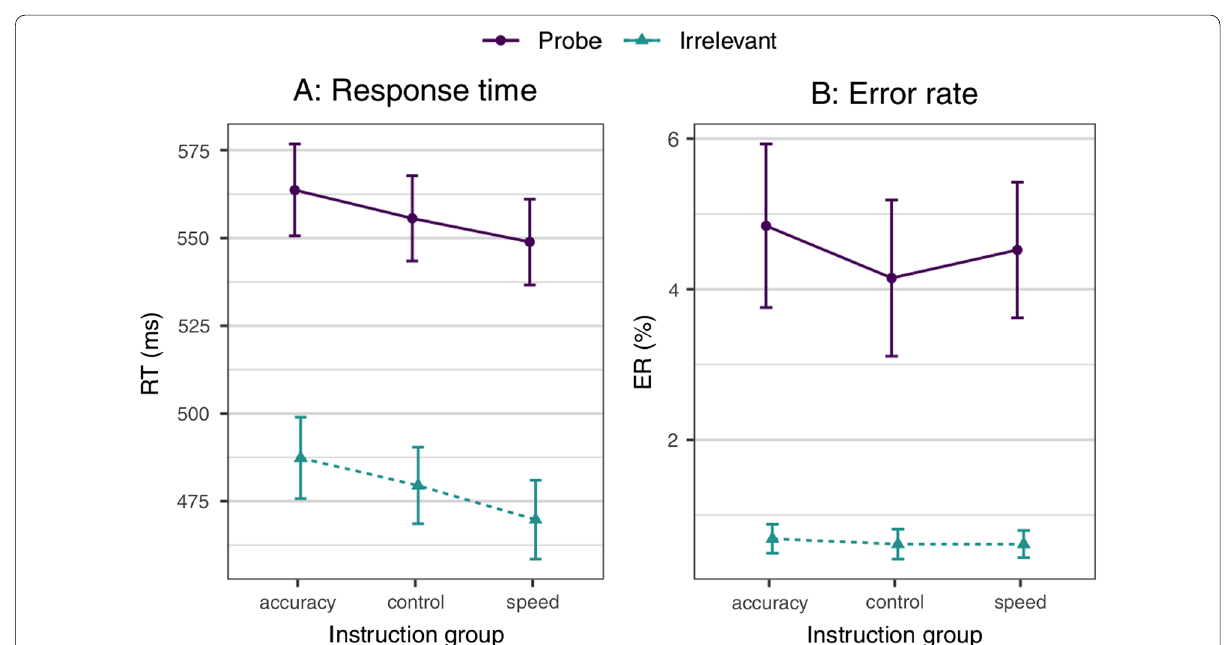
Fig. 2 Analysis of variance (ANOVA), with the factors Stimulus and Instruction. Note. Mean and SD s for the response times (RTs; left panel A ) and error rates (ERs; right panel B ) of the probe and irrelevants across the three different instruction conditions (accuracy vs. control vs.